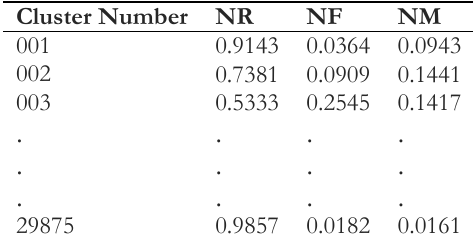
Table 2. Normalized value of data.